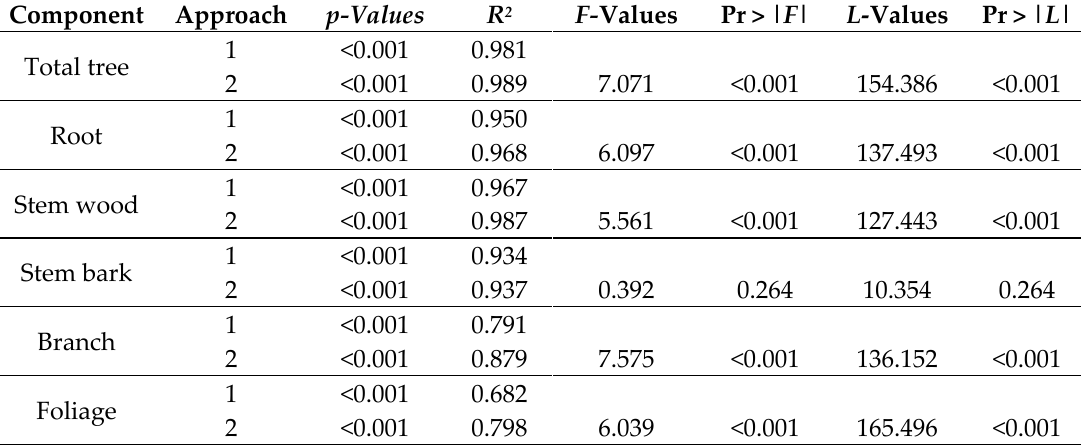
Table 6. Evaluation of the non-hierarchical and hierarchical Bayesian approaches (1 and 2 represent the non-hierarchical and hierarchical Bayesian approaches,